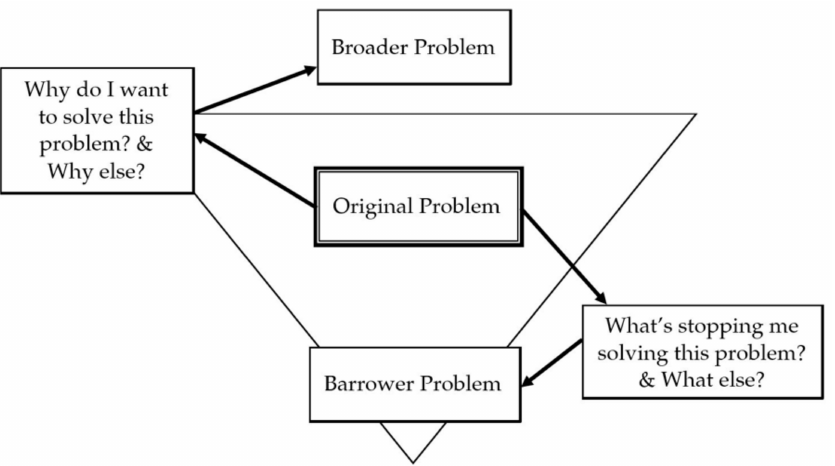
Figure 2. Problem hierarchy